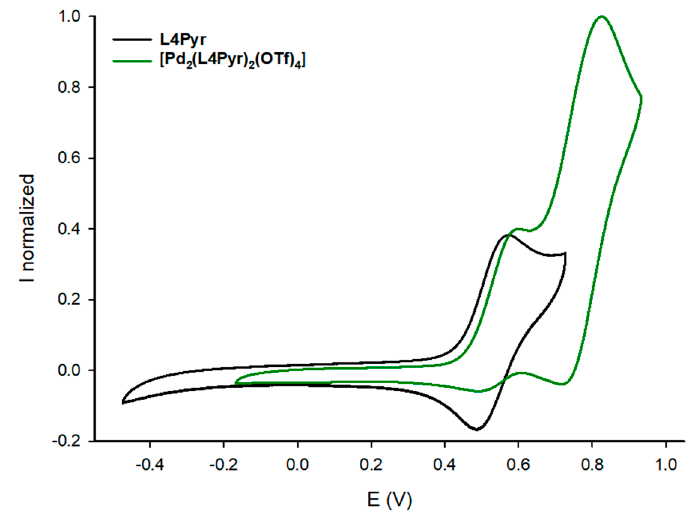
Figure 6. Normalized cyclic voltammograms of ligand L4Pyr and metalla-ring [ Pd 2 (L4Pyr) 2 (OTf) 4 ] (C = 10 − 3 M, CH 3 CN/CH 2 Cl 2 , 0.1 M nBu 4 NPF 6 , 100 mV·s − 1 , Pt) V vs. Fc/Fc + .